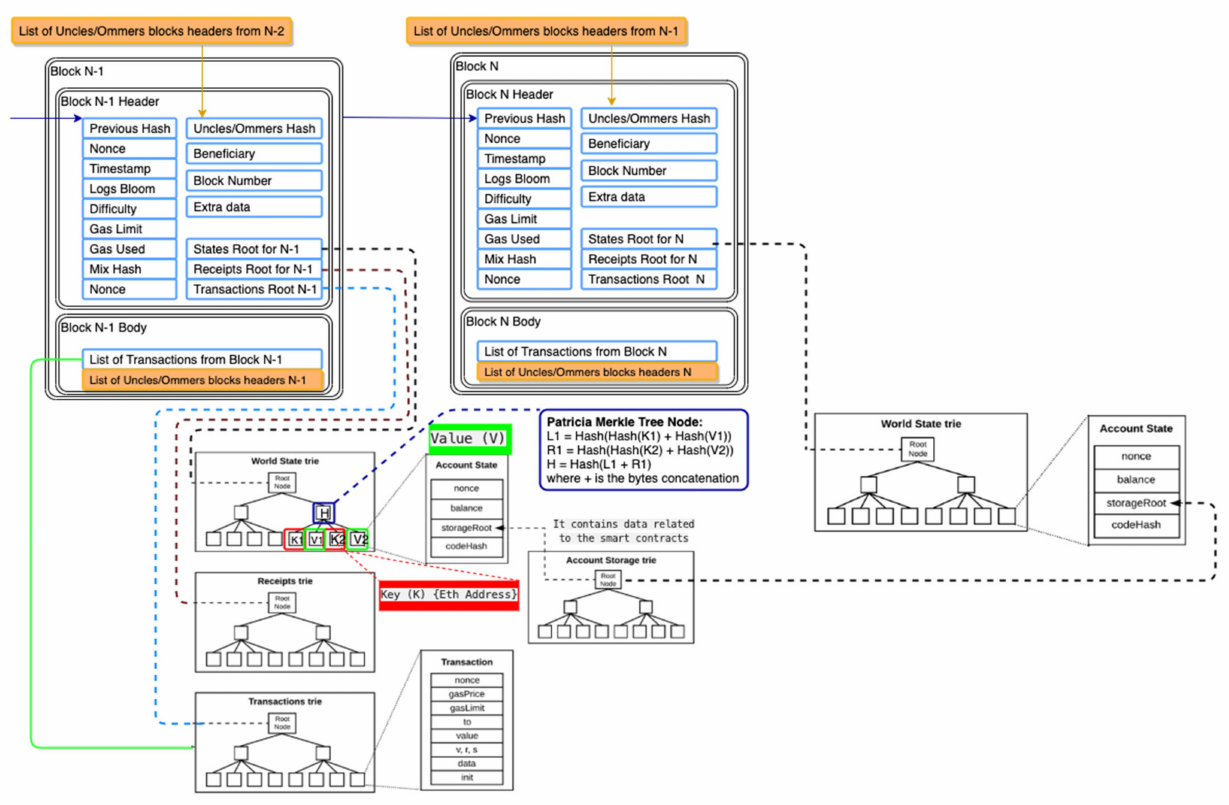
Figure 10. Ethereum block structure and the world state, receipts, and transactions in Patricia Merkle